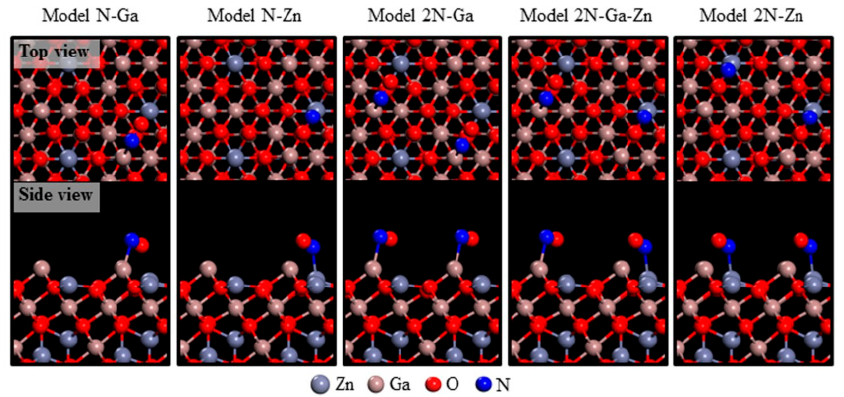
Figure 6. Atomistic representations of detailed N-Ga and/or N-Zn bonding arrangements pertaining to NO exposure on Ga-Zn-O-terminated ZGO (111) models. The atoms are represented by spheres: Zn (gray), Ga (brown), O (red), and N (blue) [27].